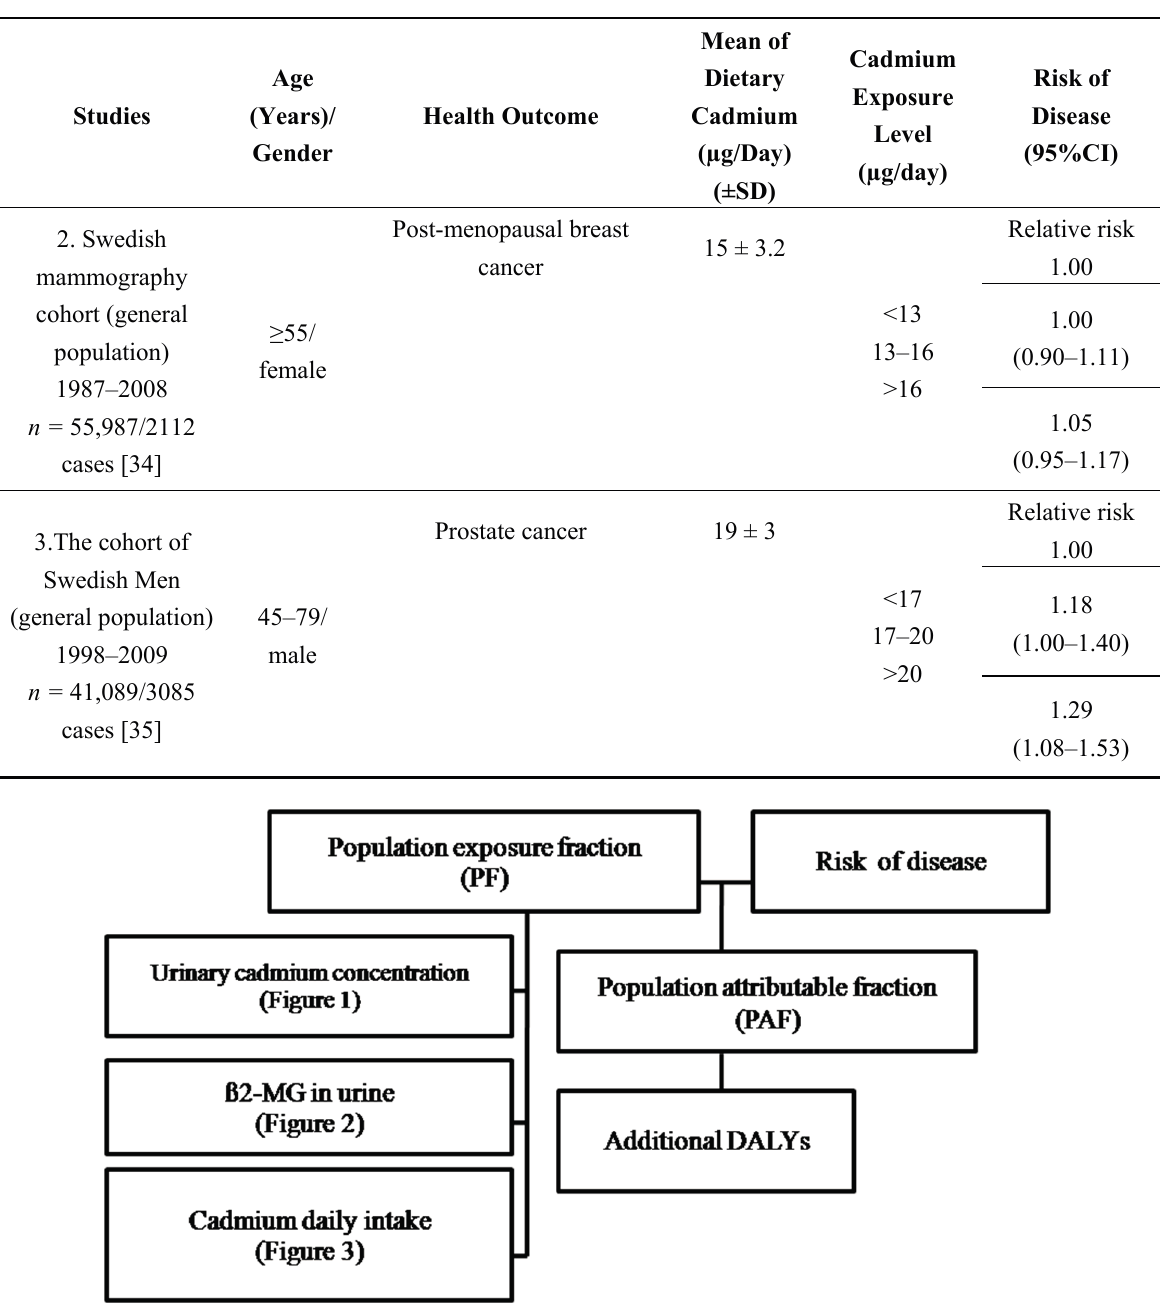
Figure 4. Diagram summarizes the process of additional DALYs attributable to cadmium estimation in Mae Sot